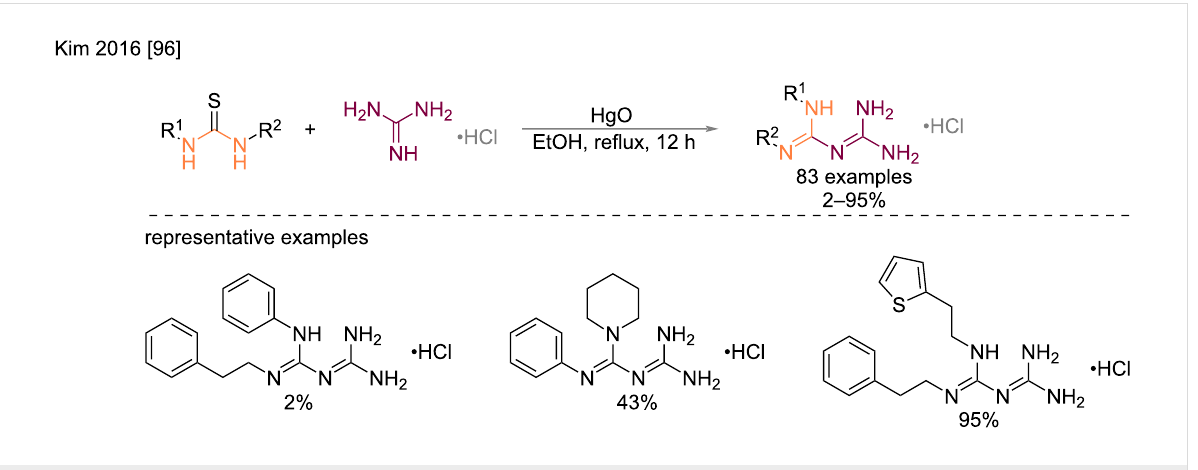
Scheme 53: Synthesis of N 1 , N 2 -disubstituted biguanides by the reaction of guanidine and thioureas in the presence of HgO